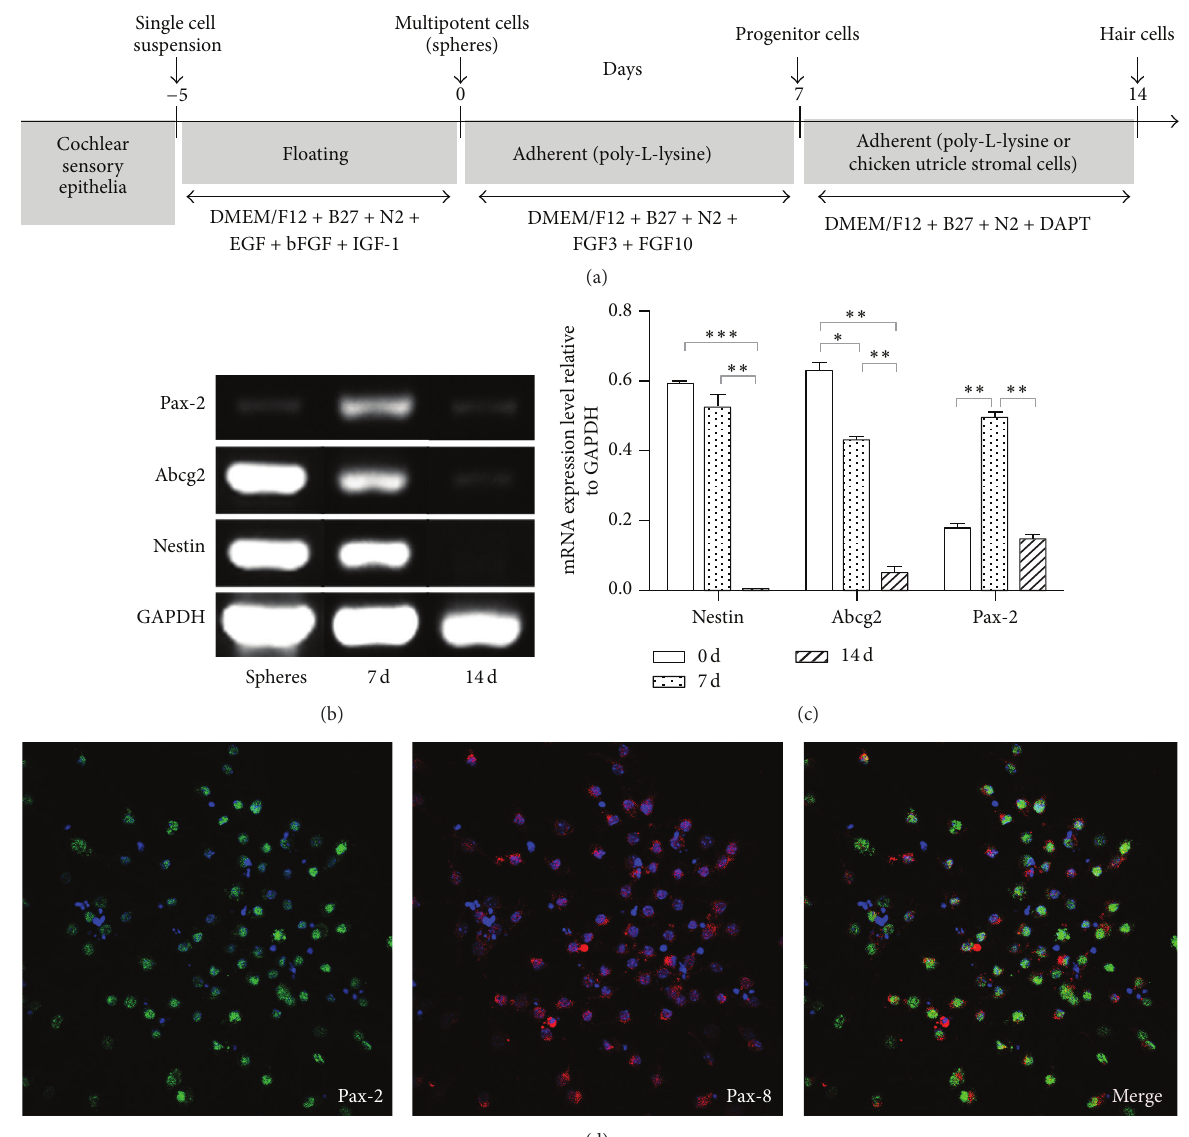
Figure 2: Gene expression of sphere cells and cells differentiated for 7 and 14 days on poly-L-lysine. (a) Spheres were generated for 5 days in presence of EGF, bFGF, and IGF-1, as indicated. Progenitor cells were generated by subsequent adherent culture for 7 days in poly-L- lysine coated plates in presence of FGF3 and FGF10. On day 7, the resulting progenitor cells were grown adherently on a poly(L-lysine) substratum or a layer of mitotically inactivated chicken utricle stromal cells for 7 days to form hair cells in presence of DAPT. (b) Reverse transcription-polymerase chain reaction (RT-PCR) expression analysis of markers of stem cells and progenitor cells of inner ear cell lineages. The ubiquitously expressed GAPDH is shown as a reference. (c) Expression of the stem cell markers Nestin and Abcg2 and the inner ear progenitor cell marker Pax-2. Spheres: spheres generated from cochlear multipotent cells, 7d: cells differentiated for 7 days on the poly-L- lysine substratum in vitro , and 14d: cells differentiated for 14 days on the poly-L-lysine substratum in vitro . Statistically significant differences between groups are indicated by ∗ 𝑃 < 0.05 , ∗∗ 𝑃 < 0.01 , and ∗∗∗ 𝑃 < 0.001 ( 𝑛 = 3 ). (d) Coexpression of the inner ear progenitor cell markers, Pax-2 (red, left) and Pax-8 (green, center), in the sphere cells. Right: merged images (left and